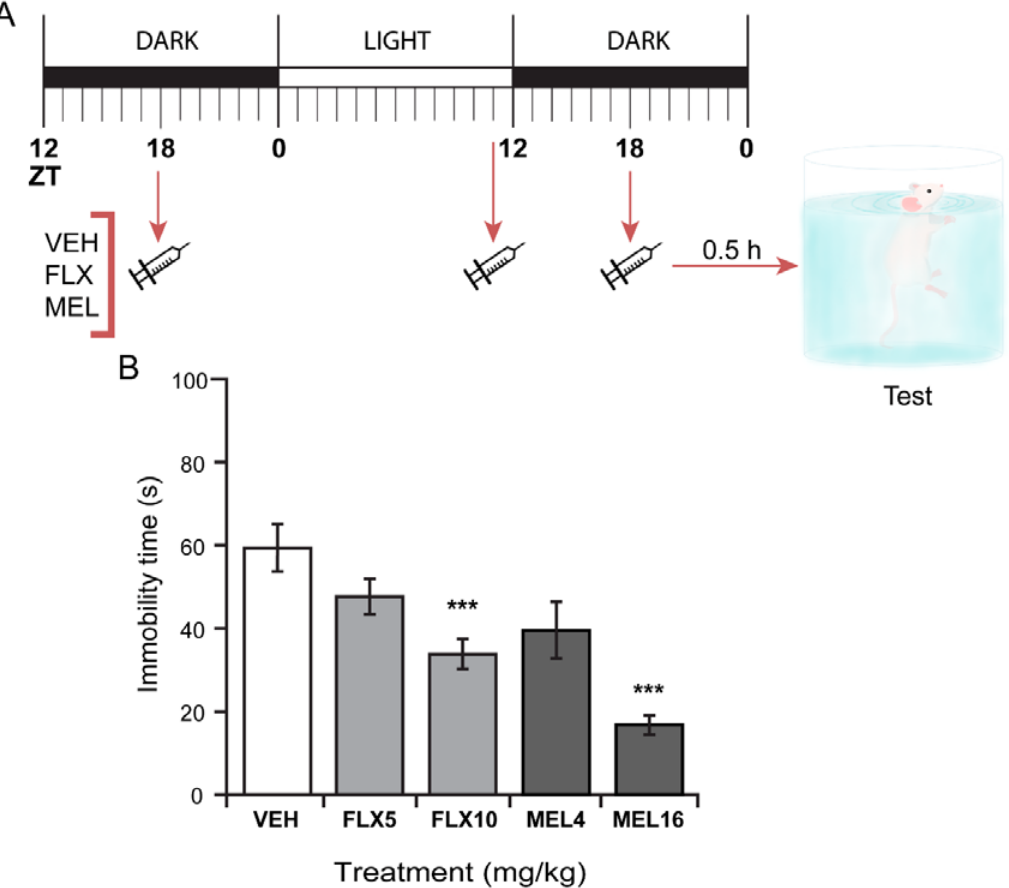
Figure 5. Effect of three doses of melatonin over a 24 h-period in the mice forced swimming test (FST). ( A ) Melatonin treatment protocol with three doses administrated at ZT18, ZT11, and ZT18. Mice were treated with either vehicle (VEH), 5 or 10 mg/kg fluoxetine (FLX5 and FLX10, respectively), or 4 or 16 mg/kg melatonin (MEL4 and MEL16, respectively). ( B ) Data shows mean and standard error of the mean for 8 mice per group. Statistically significant differences were assessed using a one-way ANOVA, followed by Bonferroni’s post-hoc test. *** p ≤ 0.001 when compared with the VEH-treated group.